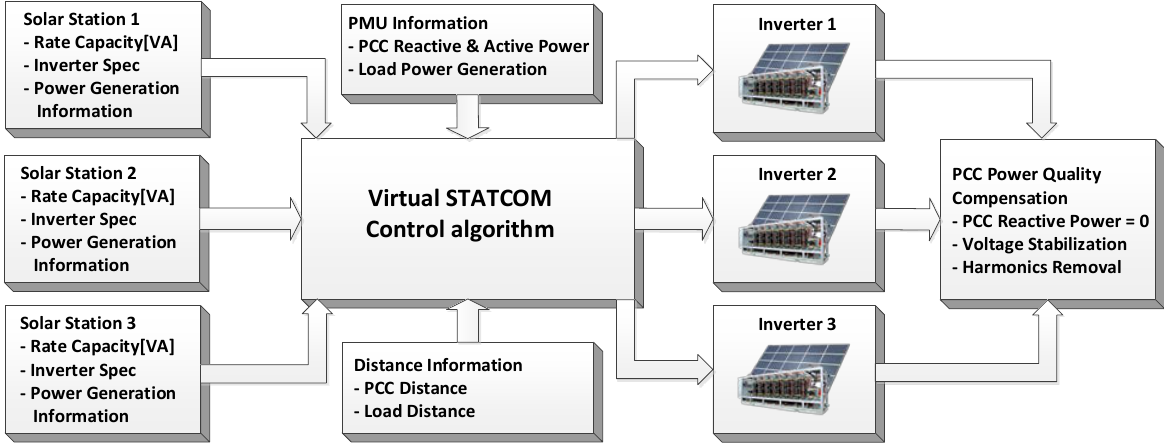
Figure 5. Configuration of Virtual STATCOM Integrated Control Algorithm.